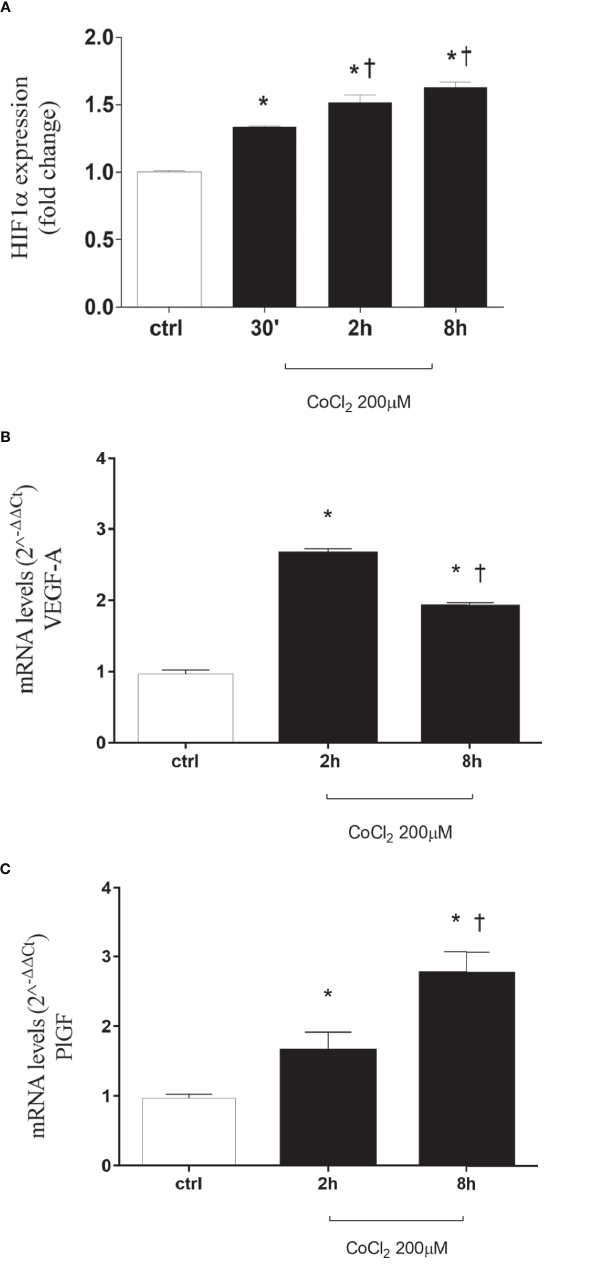
FIGURE 1 | CoCl 2 treatment induces HIF-1 a stabilization, vascular endothelial growth factor (VEGFA), and placental growth factor (PlGF) expression in human retinal endothelial cells. (A) Densitometric analysis of western blot of HIF-1 a and GAPDH in human retinal endothelial cells (HRECs) exposed to CoCl 2 for 30 min, 2 h and 8 h; each bar represents the mean value ± SD (n=4). *p< 0.05 vs. control; † p < 0.05 vs. 30 min CoCl 2 treatments. (B) CoCl 2 treatment increased VEGF-A mRNA expression. Each bar represents the mean value ± SD. *p < 0.05 CoCl 2 vs. control; † p < 0.05 8 h vs. 2 h CoCl 2 treatment; (n=4). (C) CoCl 2 treatment increased PlGF mRNA expression. Each bar represents the mean value ± SD. *p < 0.05 CoCl 2 vs. control; † p < 0.05 8 h vs. 2 h CoCl 2 treatment; (n=4). The mRNA levels were evaluated by